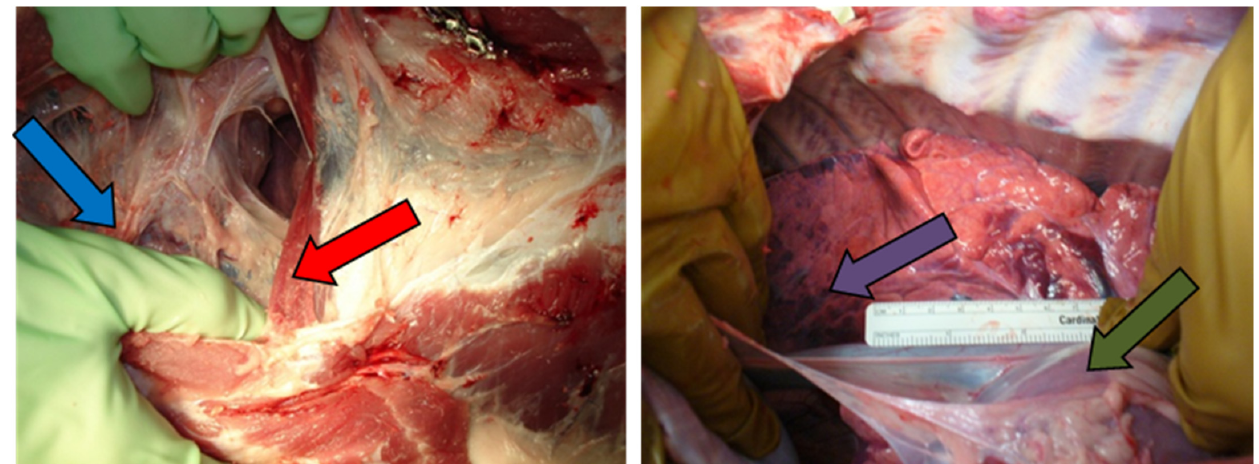
Figure 4. Macroscopic findings during necropsy: adhesions (blue arrow), increased diaphragm thickness (red arrow), abnormal color in the lungs (purple arrow), and increased pericardium thick-